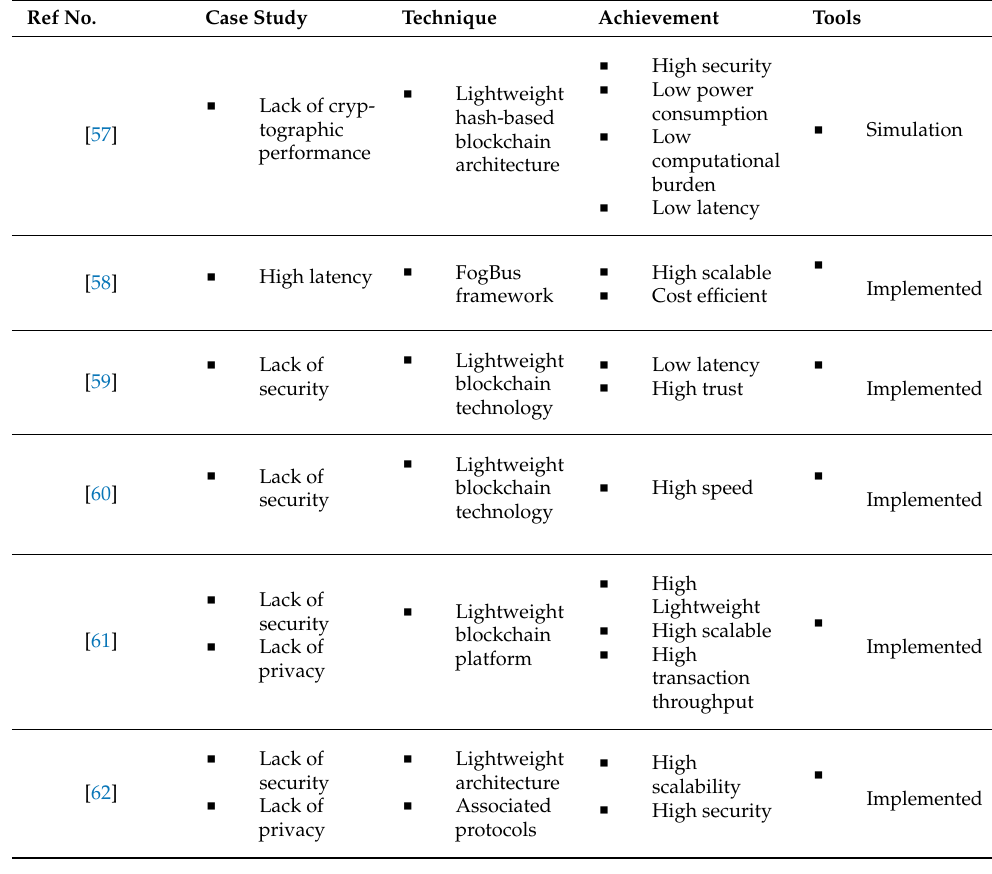
Table 3. Selected Articles.